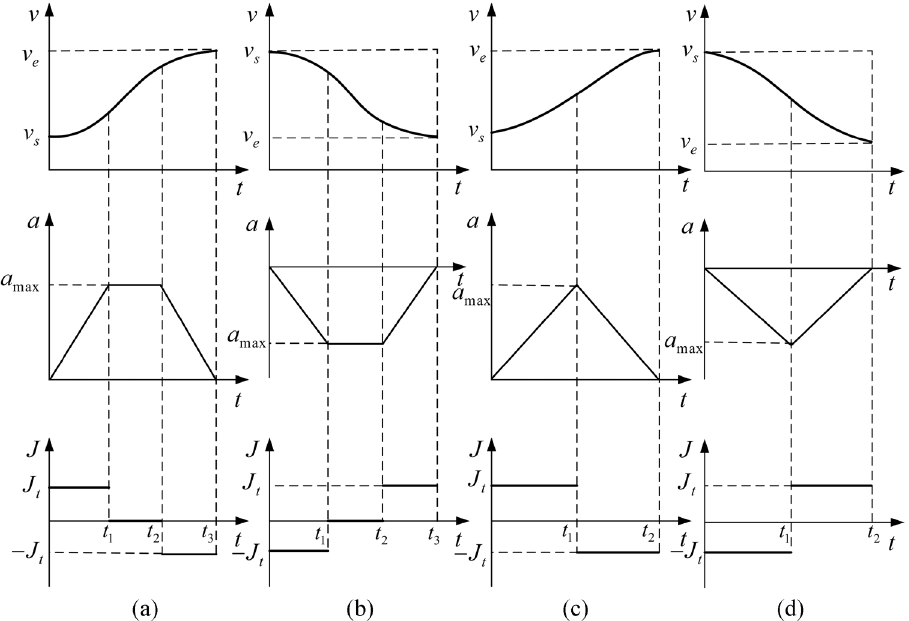
Figure 4. S-type acceleration and deceleration planning of ( a ) Elevated acceleration-constant rate-reduced acceleration, ( b ) Reduced acceleration-constant rate-reduced deceleration, ( c ) Elevated acceleration-elevated deceleration, ( d ) Reduced acceleration-reduced